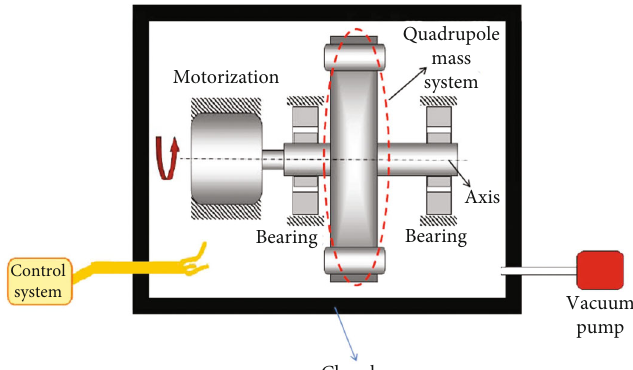
Figure 2: Mechanical system to generate the rotation of the emitter. Source: from the authors.